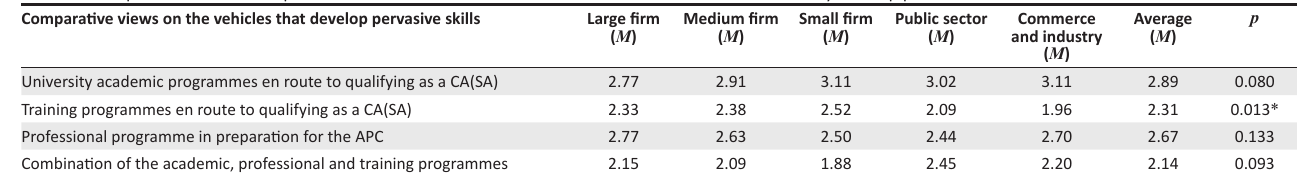
TABLE 4: Comparative results of aspirant chartered accountants’ views on the vehicles that most effectively develop pervasive skills. Comparative views on the vehicles that develop pervasive